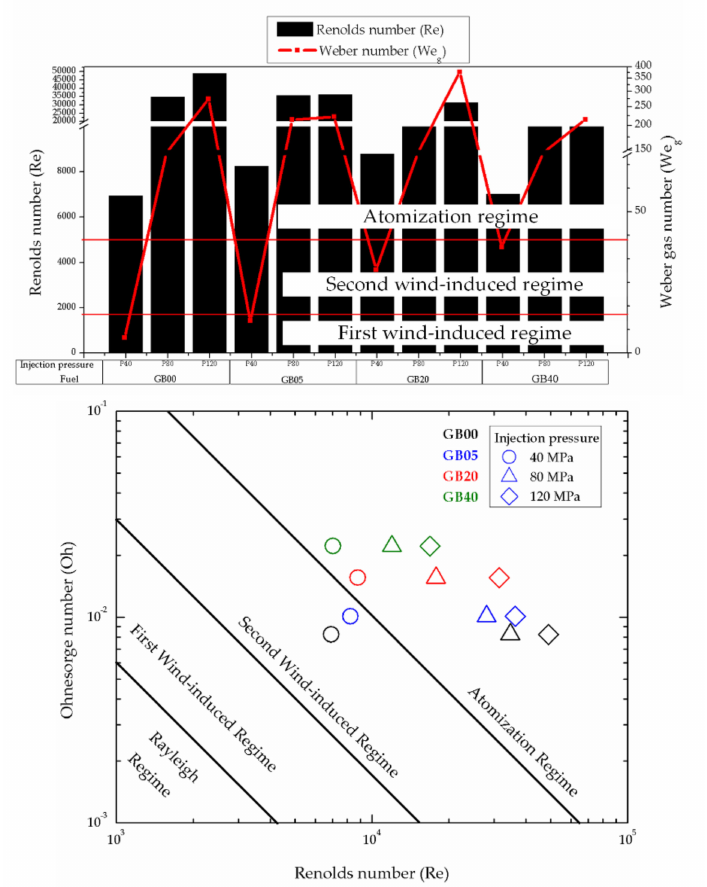
Figure 8. Spray atomization regimes of GB fuels during the initial spray development, according to the injection pressure (GB00: gasoline 100% and biodiesel 0%, GB05: gasoline 95% and biodiesel 5%, GB20: gasoline 80% and biodiesel 20%, GB40: gasoline 60% and biodiesel